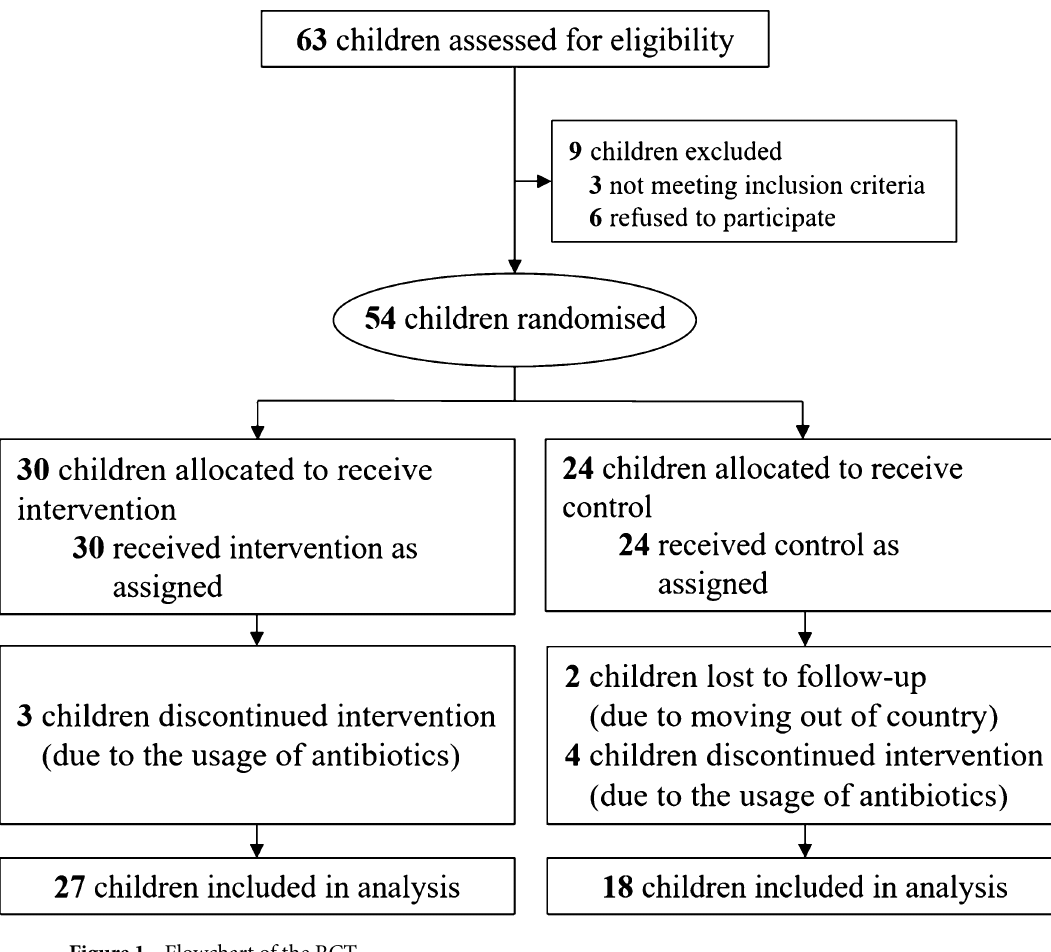
Figure 1. Flowchart of the